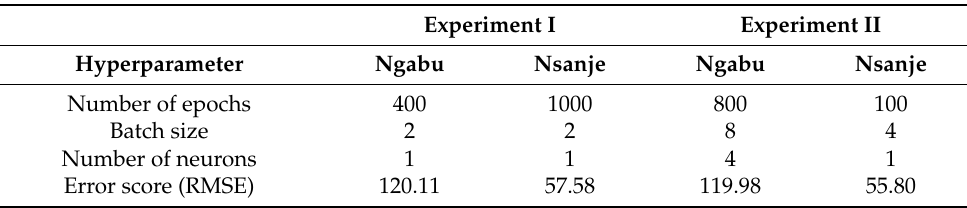
Figure 9. Box & whisker plots for each of the hyperparameters in the LSTM models across the various experiments. Table 7. Optimal hyperparameter settings for each of the